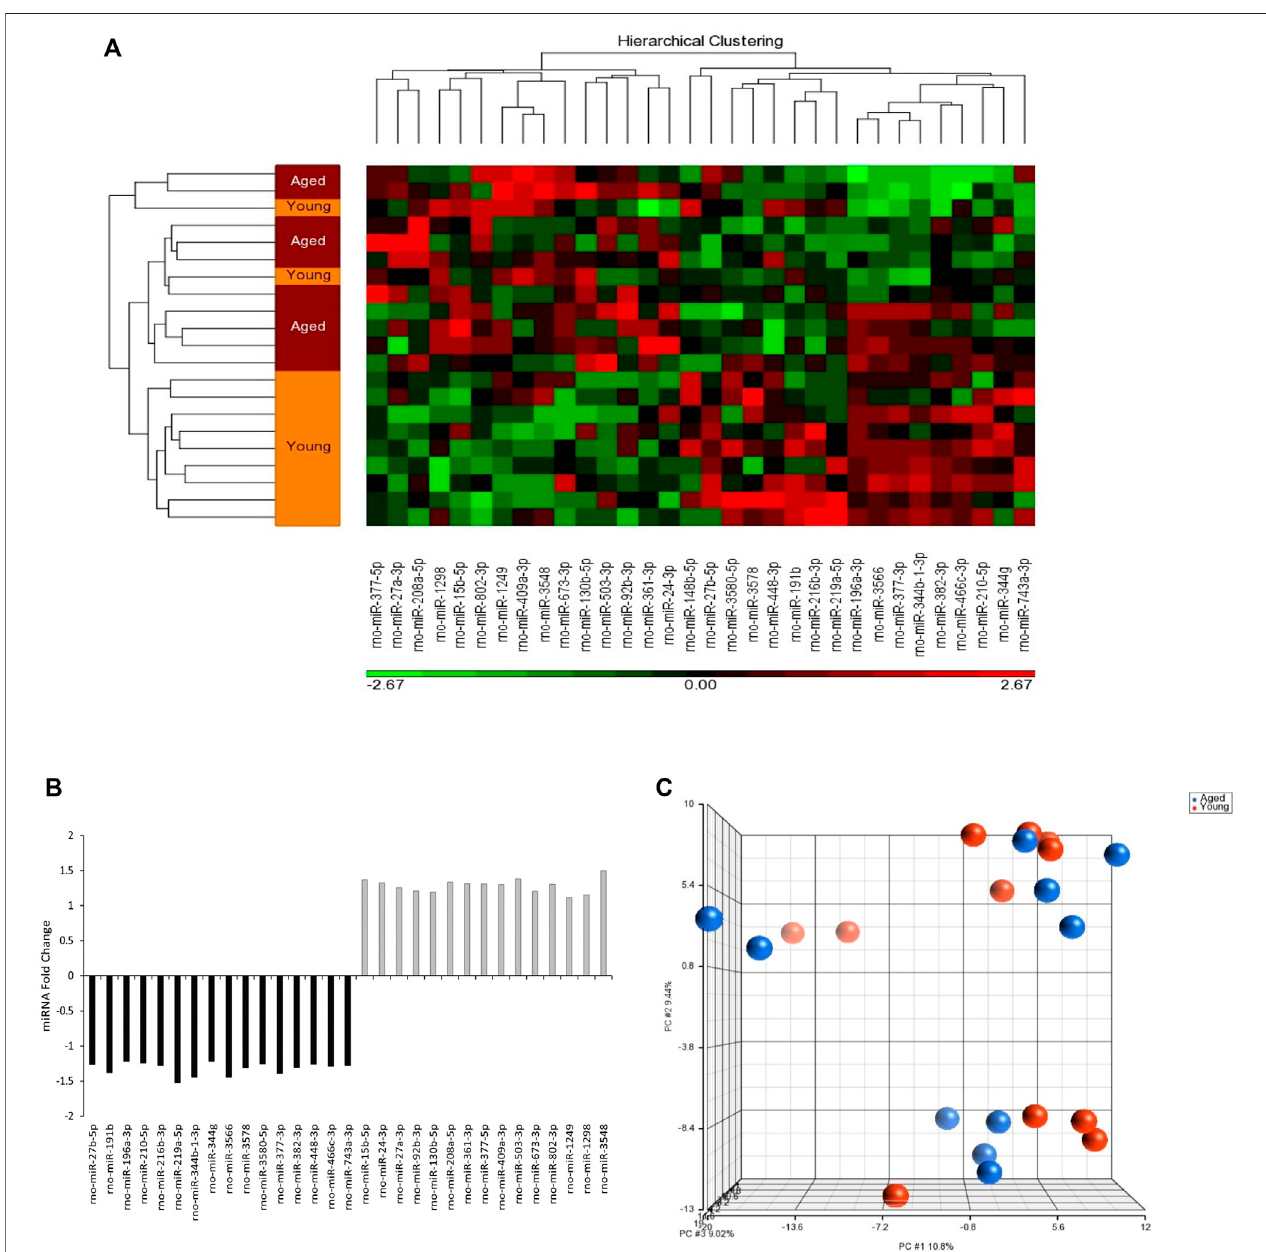
FIGURE 1 | MicroRNAs (miRNAs) content in circulating adipocyte-derived EVPs obtained from aged Wistar rats differs from those of young adult ones. (A) Heatmap showing z-score and hierarchical clustering of the 32 miRNAs impacted in circulating adipocyte-derived EVPs by aging process. The microRNAs signi fi cantly expressed are shown on the bottom. Color gradation shows the relative microRNA content in circulating adipocyte-derived EVPs obtained from aged Wistar rats compared with those from young adult ones: green, downregulation; red, upregulation. (B) The fold change of miRNAs altered in circulating adipocyte-derived EVPs obtained from aged compared with young adult rats (One-way ANOVA, p < 0.05; fold change ≥ |1.1|). (C) Principal coordinates analysis (PCA) plot comparing differentlymiRNAs contentincirculatingadipocyte-derivedEVPs fromagedandyoung-adultanimals.EachdotrepresentstheoverallmiRNA expressionineach animal. The distance between dots indicates their dissimilarity. PCA and hierarchical clustering were performed with Partek Genomics Suite (version 6.6; Partek, St. Louis, MO, United States).